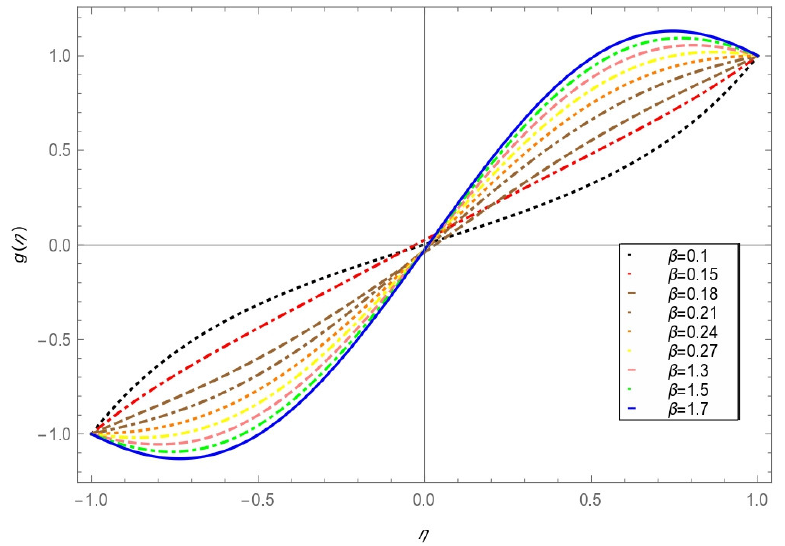
Figure 7. Radial velocity profile effect of the porosity parameter for α = 2, Re = 1, ϕ 1 = ϕ 2 = 0.03, dp 1 = dp 2 = 10, M = 1, Fr = 0.1.